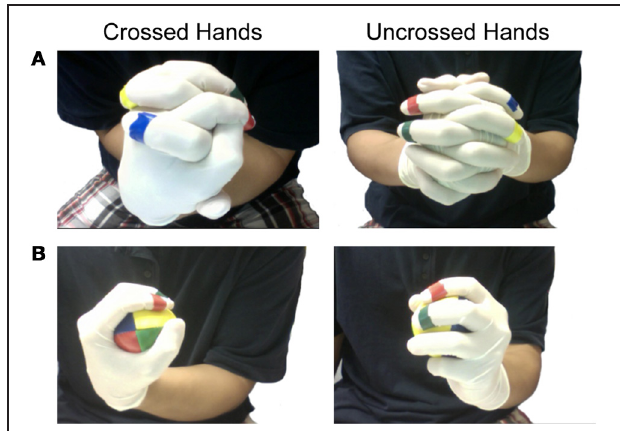
FIGURE 1 | Hand and finger postures. (A) Example of the hand and finger posture for the Hand-Reversal Illusion (left) and a naturally folded hand posture (right). (B) Hand and finger postures with the ball in Experiment